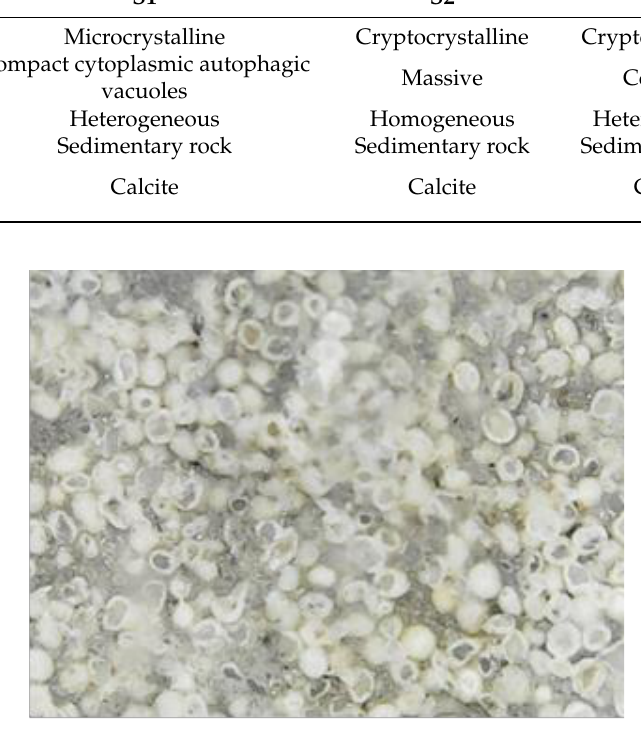
Figure 4. S1 sample series; magnification 500 X.